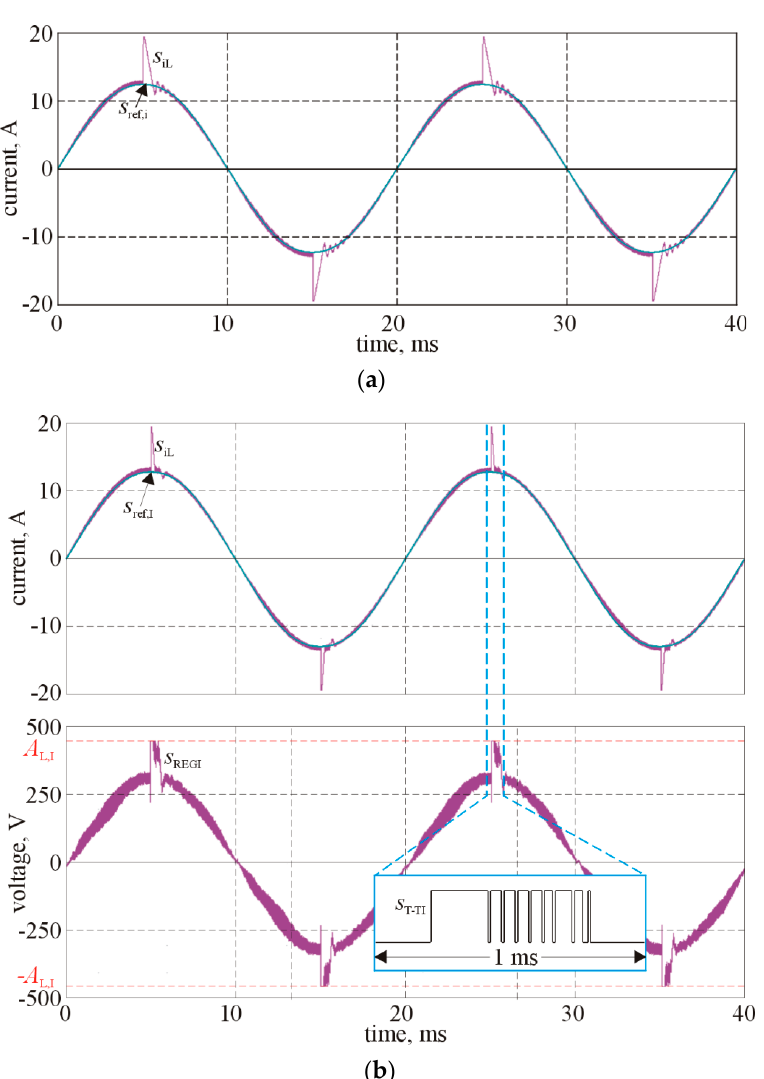
sation function was disabled.